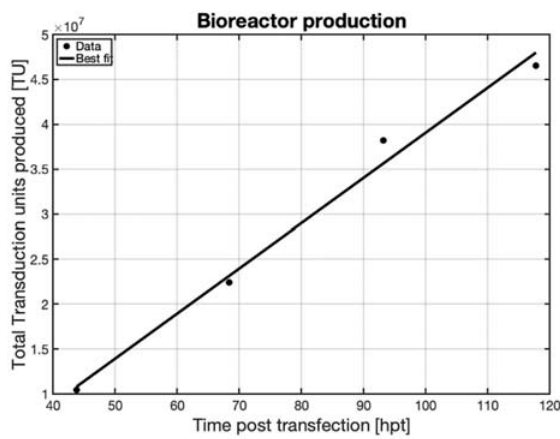
Figure 9. Total accumulated transduction units produced in the DASBox bioreactor operated in perfusion with a working volume of 150 mL and transfected with 11.44 µg DNA mL − 1 , indicating that AAV was produced until the last day, day 5.